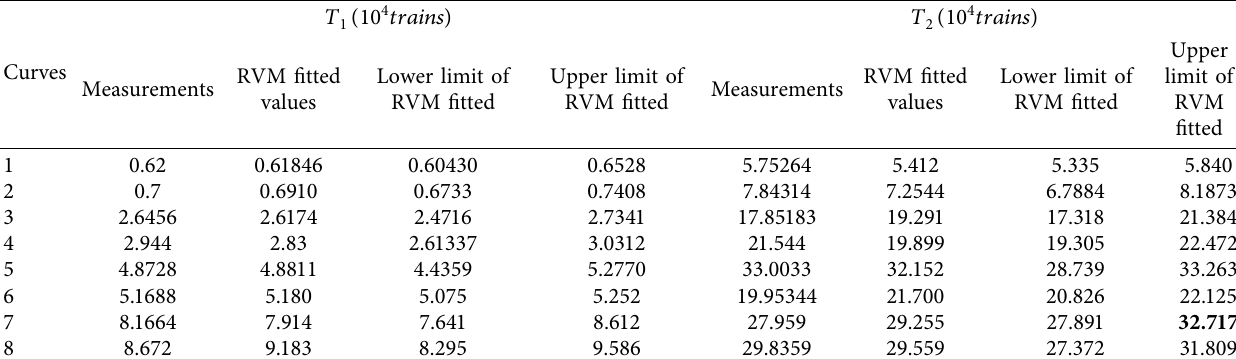
Table 4: Confidence interval obtained from RVM